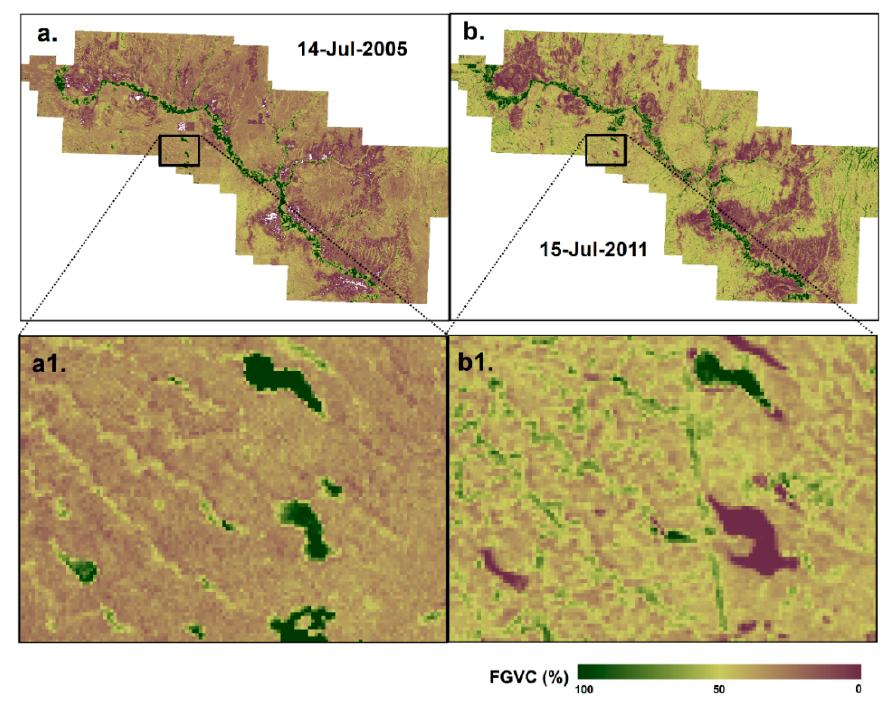
Figure 10. Two spectral unmixing green vegetation cover maps using Landsat images acquired from 15 July 2005 ( a , a1 from a dry year) and 15 July 2011 ( b , b1 from a wet year). FGVC trends from the year 1999 to 2014 were mapped over the entire study area (Figure 11a). An increase in FGVC of less than 1% per year is observed in most of the study area. Only a small portion of the study area has experienced a decreasing trend, mainly along the Frenchman River and its tributaries, with a reduced rate of less than 1% per year. Significant changes, both increasing and decreasing (Figure 11b), occurred mainly in the west half of the study area or along the river. Figure 11. FGVC trend over the study period (a) and their significant level (b). The unmixed FGVC for badlands, uplands, and riparian zone were further extracted from each FGVC map, and their temporal variations are displayed in Figure 12. FGVC is always higher in the riparian zone, followed by the uplands and then the badlands. Consistent with the significance map (Figure 11b), the linear regression trend lines in Figure 12a also suggest a slight increase in FGVC in the uplands and badlands but a decrease in the riparian zone. The vegetation greenness in badlands and uplands are most highly correlated with the total precipitation accumulated from 3 days before the images were taken (Table 2). Similarly, the last 3-day total precipitation also showed a slightly increasing trend during the study period (Figure 12b). On the other hand, vegetation greenness in